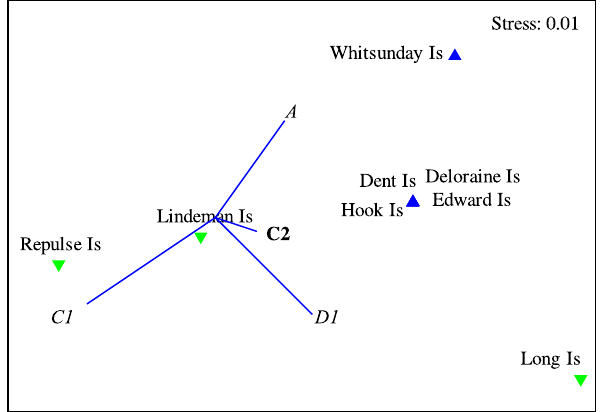
Figure 5. Two-dimensional MDS plot of the Symbiodinium community sampled at each of two water quality zones along a gradient in the Whitsunday Islands of the Great Barrier Reef. Symbols: . inner zone, m outer zone. For symbiont types, bold indicates a dominant type and italics are those occurring at background levels. Locations defined as occurring in inner and outer zones of water quality using thresholds described by De’ath and Fabricius (2010) [37].